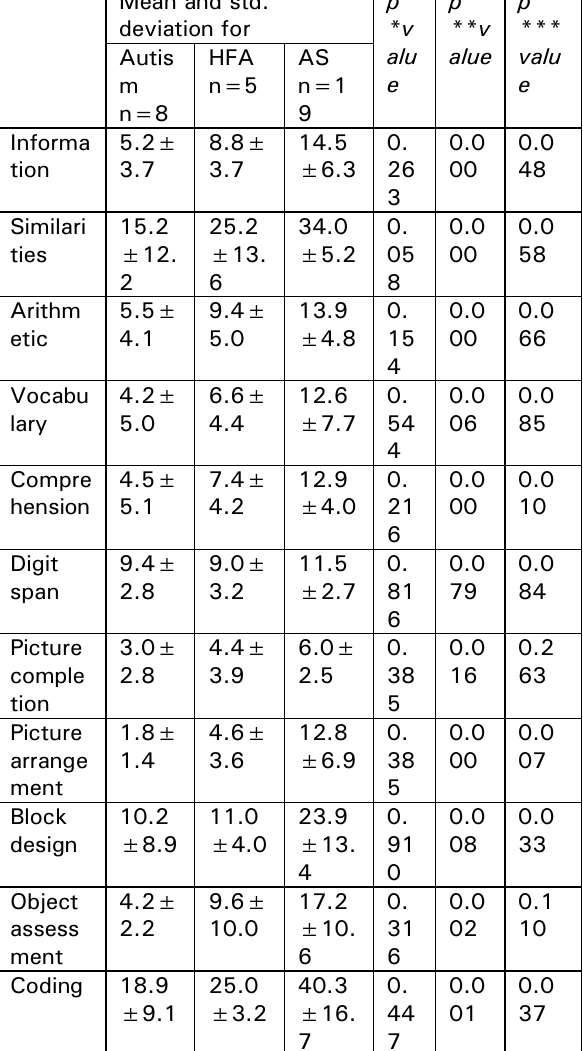
Table 2: C-WISC between autism, HFA and AS children Mean and